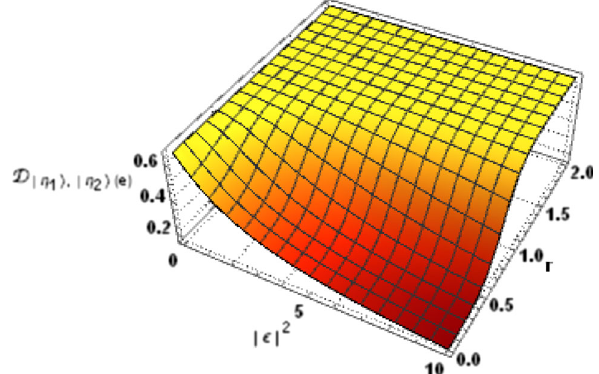
Fig. 13 Figure 12 and this figure are plots for the D T in | η 1 (cid:3) and | η 2 (cid:3) states of TMSEC states, plotted as a function of coherent parameter | (cid:11) | and squeezing parameter r . Note that | η semiclassical states with D T (cid:10) 1 only when | (cid:11) | (cid:14) r , otherwise the states are very quantum with D T ≈ 1